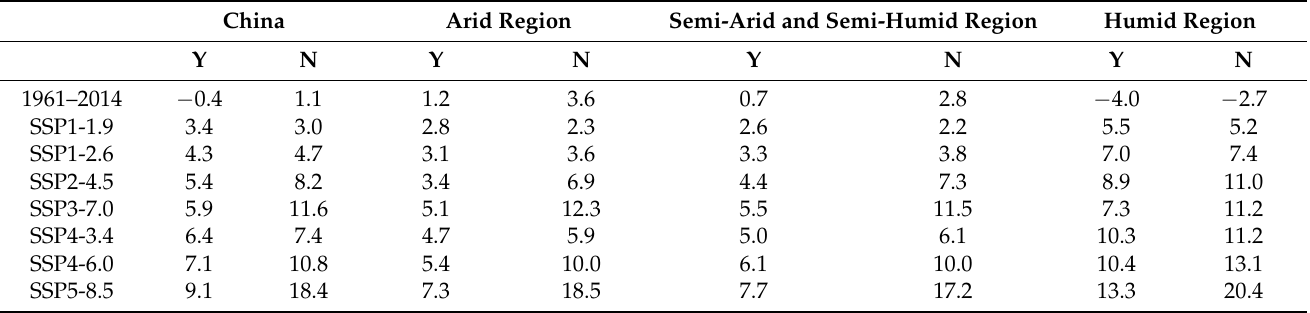
Table 2. Trends of annual PET in China and the three climatic zones for 1961–2014 and 2015–2100 under the seven SSPs (unit: